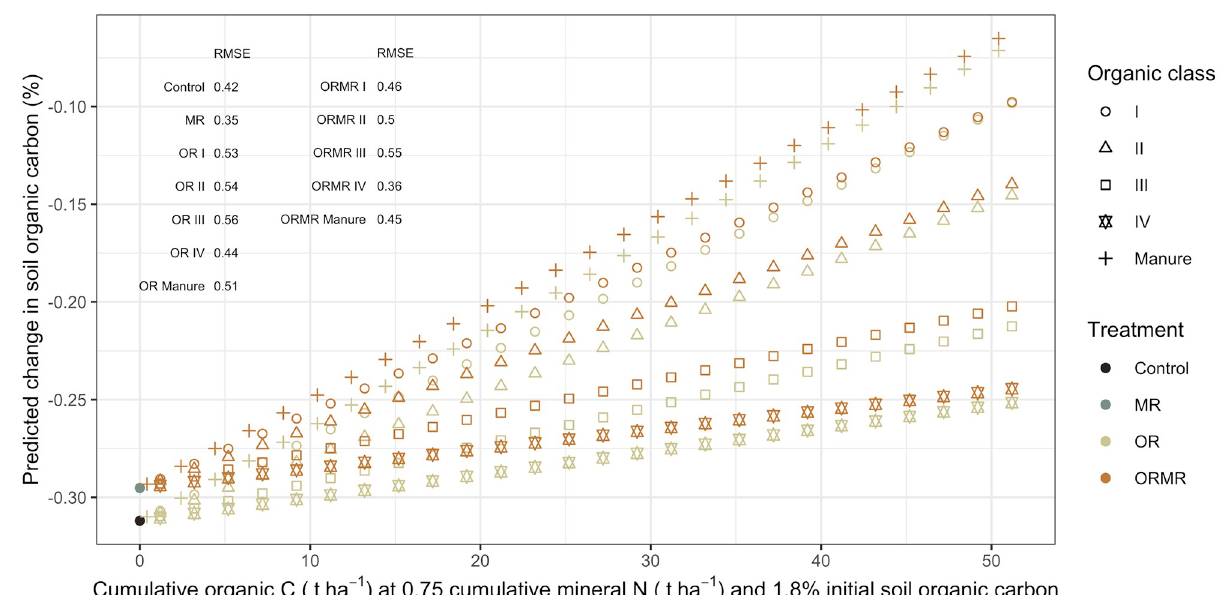
Fig 10. The output of the C-SOC model is used to predict changes in soil organic carbon from its initial values (dSOC) across cumulative organic carbon input rates. These are then plotted for each treatment and organic class, and at an initial SOC of 1.8% and cumulative mineral N input of 750 kg ha -1 . The 750 kg ha -1 was based on an annual mineral N application of 75 kg during a time frame of 10 years. The root mean square error (RMSE, in %) is given for the dSOC predictions of the different subtreatments.